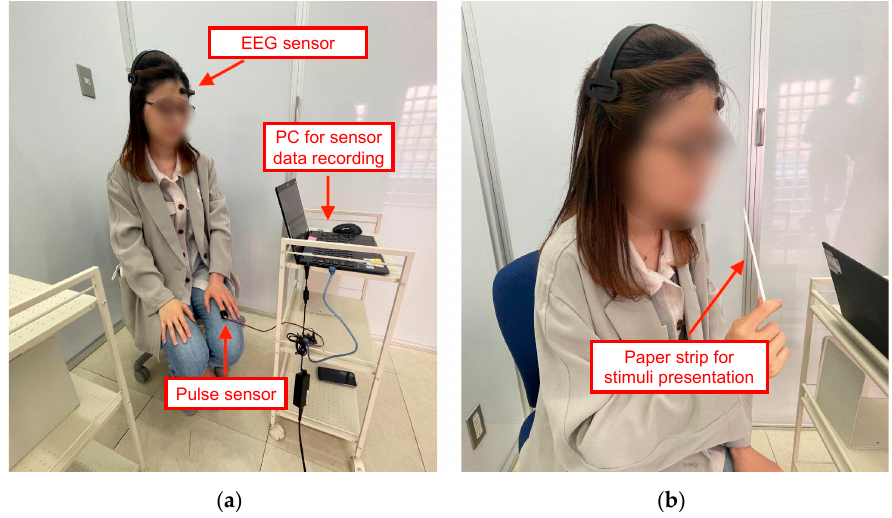
Figure 3. Experimental scene ( a ) when a tt aching sensors and ( b ) during stimulus presentation.